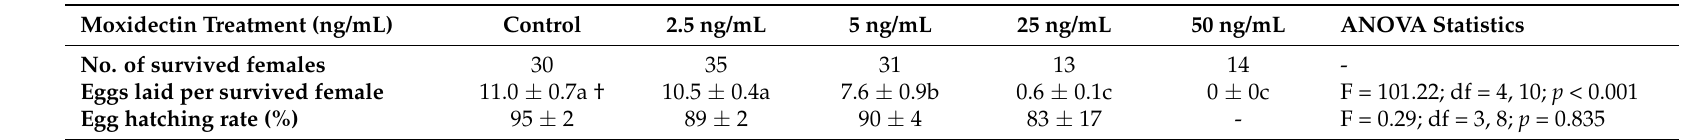
Table 2. Effect of moxidectin on bed bug female fecundity and egg hatching after 1 week.